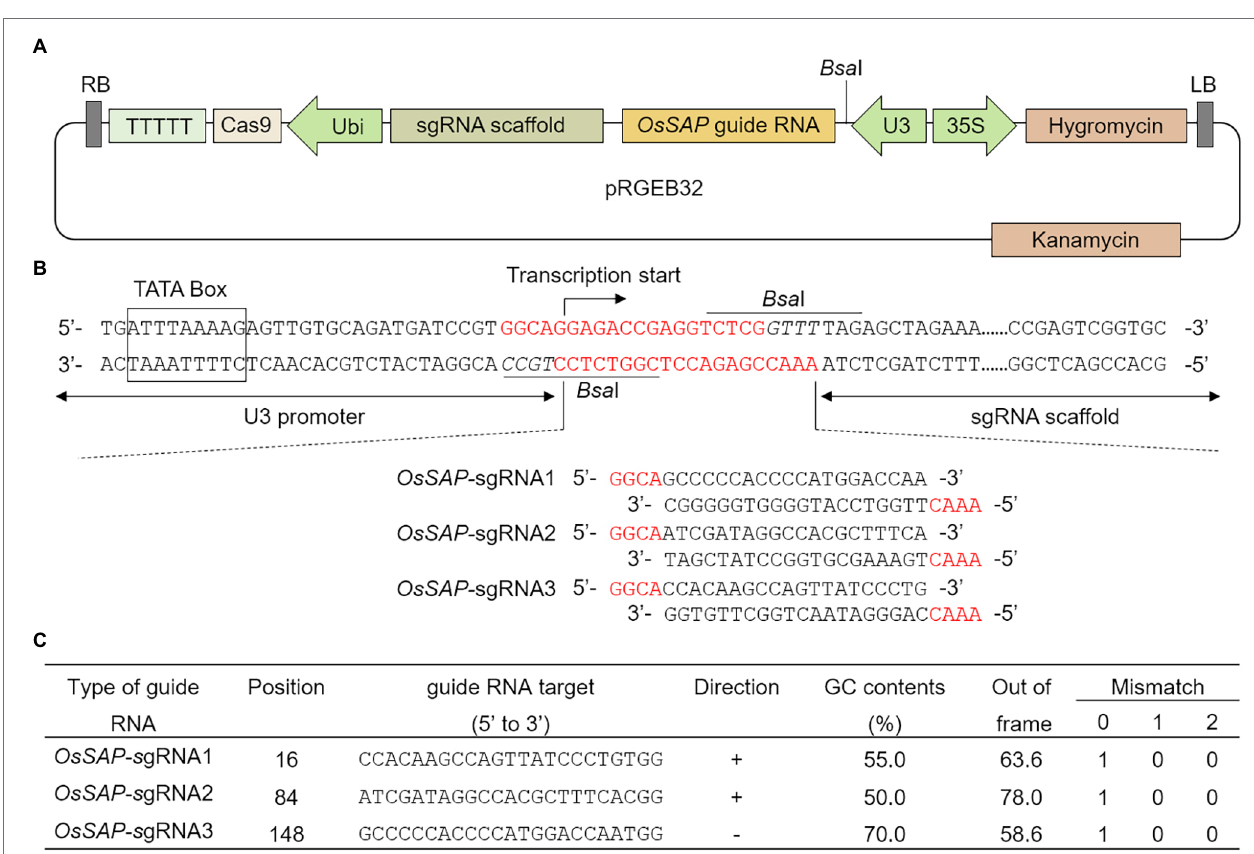
FIGURE 1 | CRISPR/Cas9 vector construct and guide RNA design for Oryza sativa Senescence-associated protein ( OsSAP ) genome editing. (A) Schematic diagram of the pRGEB32 vector used for genome editing of OsSAP through CRISPR/Cas9 expression in rice. The guide RNA and sgRNA scaffold are expressed by the U3 promoter. Cas9 is expressed by the ubiquitin promoter (Ubi). Hygromycin (HPT) is expressed by the CaMV35S promoters (35S). LB and RB: left border and right border, respectively. (B) In the CRISPR/Cas9 vector, OsSAP guide RNA inserted at the site of the Bsa I restriction enzyme site. (C) Three sgRNAs were designed for genome editing of OsSAP . The GC content of guide RNAs was set to 50–70%. Out-of-frame and mismatch values indicate the possibility that the guide RNA will act off-target. The out-of-frame value was set to 60 or more, and a mismatch of 1-0-0 meant that the designed guide RNA does not have the same sequence as OsSAP